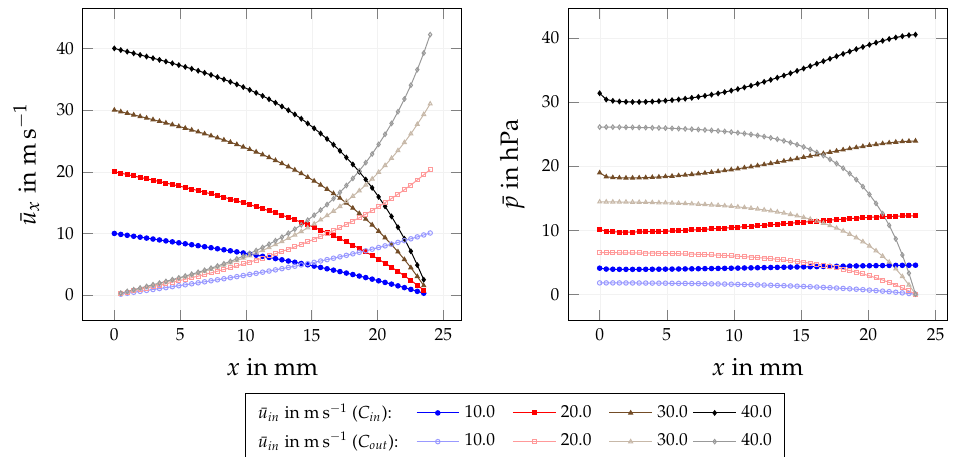
Figure 9. Velocity profiles ¯ u x ( x ) and pressure profiles ¯ p ( x ) in inlet channel domain C in and outlet channel domain C out with a resolution of N =